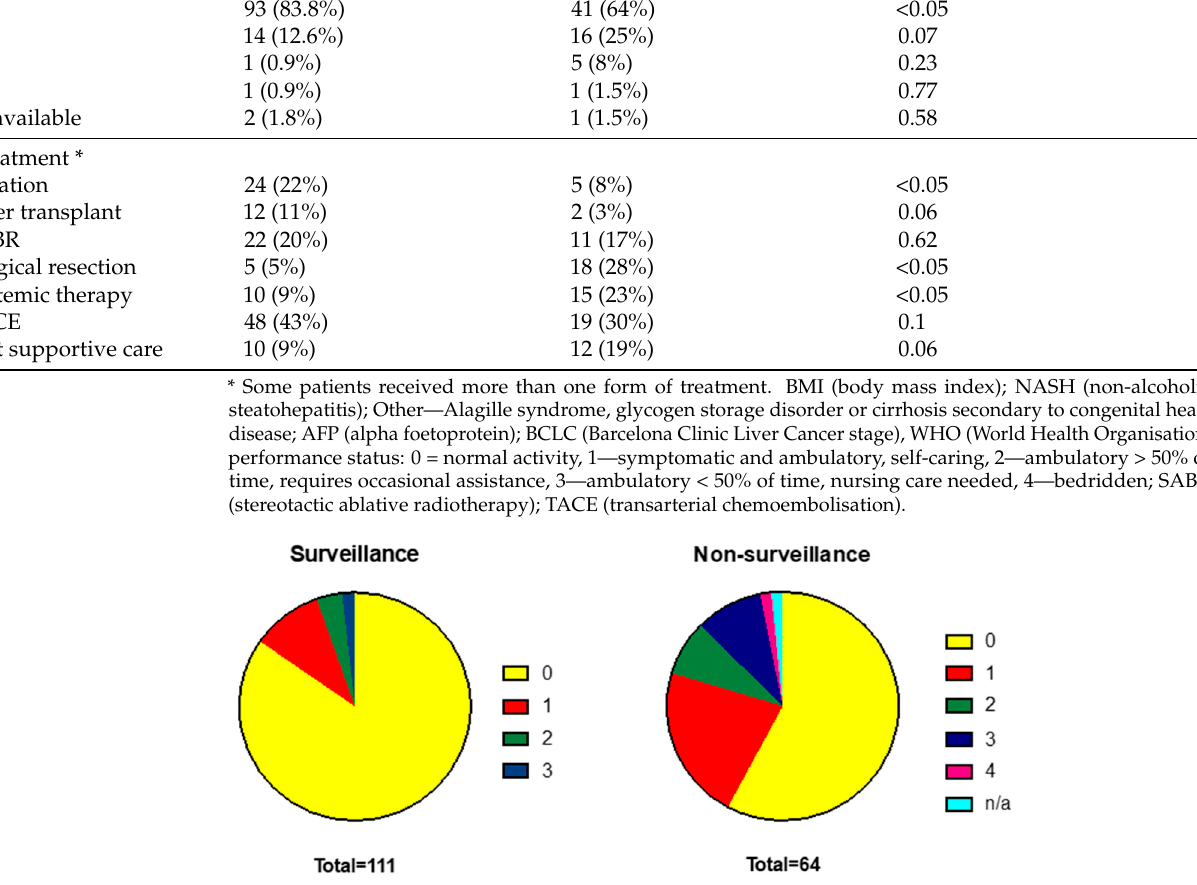
Figure 2. WHO performance status is more advanced in patients diagnosed outside a surveillance programme. WHO Performance Status: 0 = normal activity, 1—symptomatic and ambulatory, self- caring, 2—ambulatory >50% of time, requires occasional assistance, 3—ambulatory <50% of time, nursing care needed, 4—bedridden.